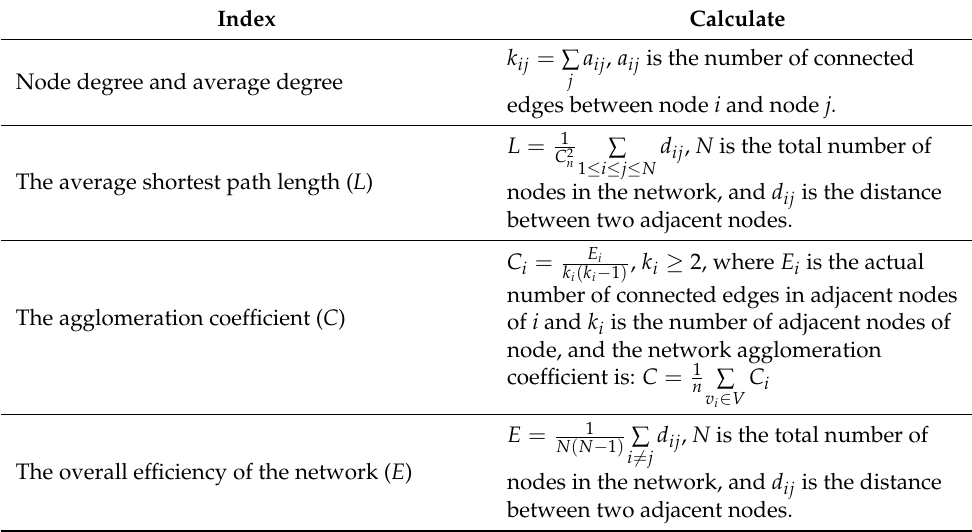
Table 4. Index and its calculation formula details